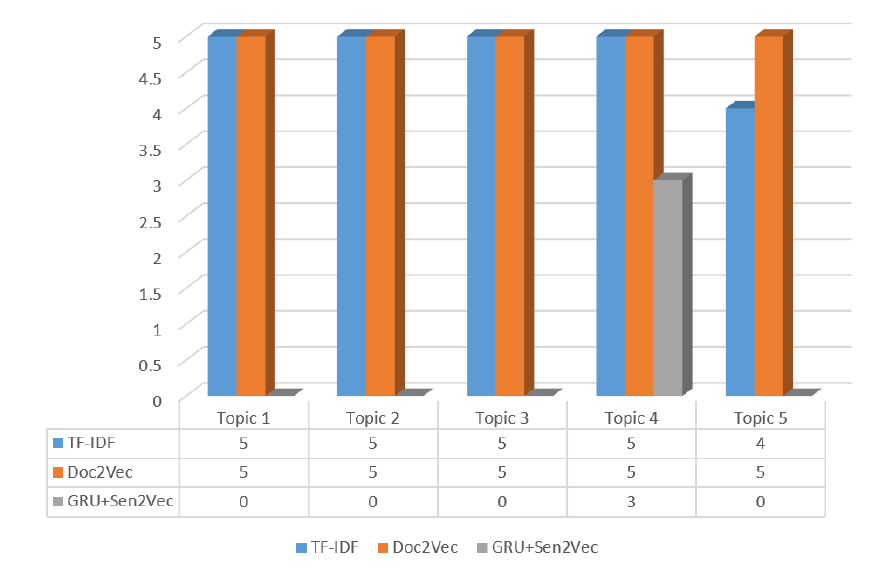
Figure 12. Human Evaluation